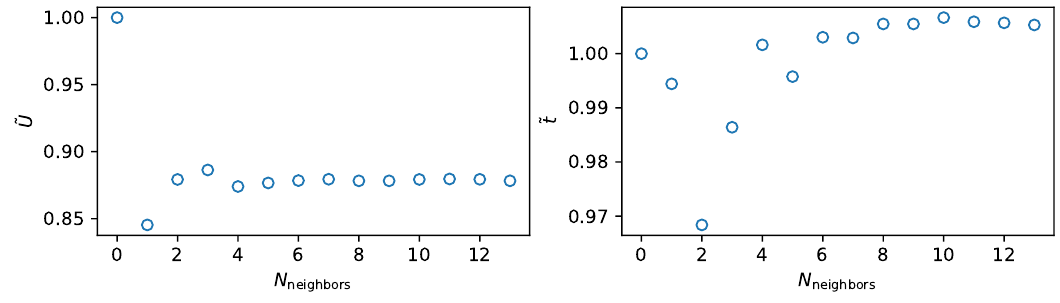
Figure 9: Convergence of the effective parameters with the number of neighbors considered in their calculation in the Coulomb case for U = 1, t = 1, V β =